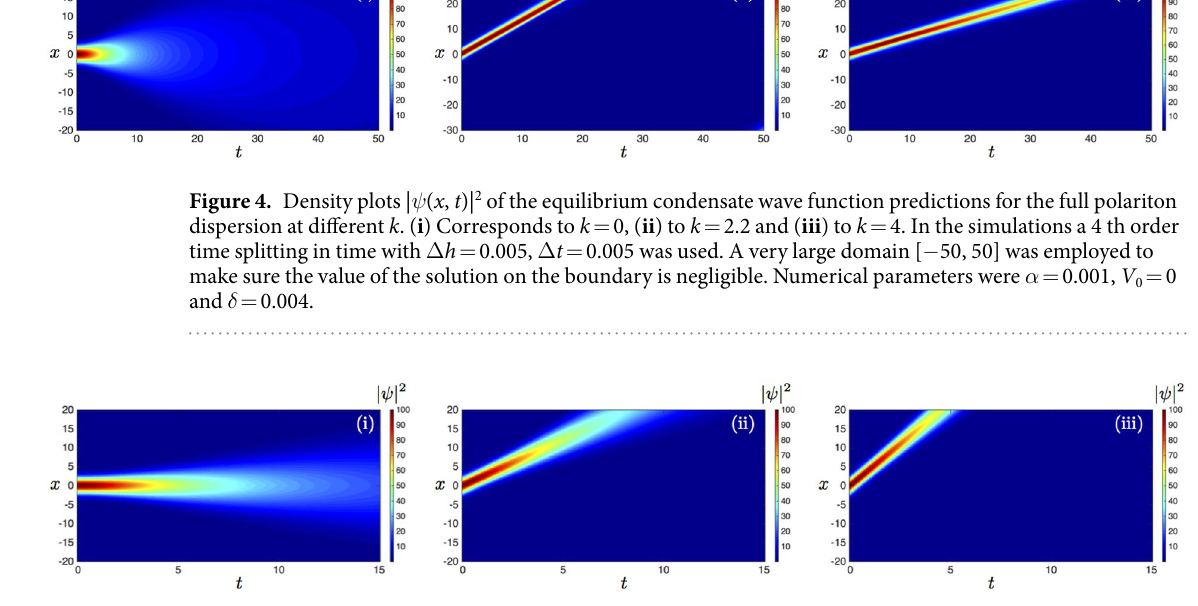
Figure 5. Density plots | ψ ( x , t )| 2 of the equilibrium condensate wave function predictions for the parabolic polariton dispersion at different k . ( i ) Corresponds to k = 0, ( ii ) to k = 2.2 and ( iii ) to k = 4. In the simulations a 4 th order time splitting in time with Δ h = 0.005, Δ t = 0.005 was used. A very large domain [ − 50, 50] was employed to make sure the value of the solution on the boundary is negligible. Numerical parameters were = 0 and δ = α = 0.001, V 0